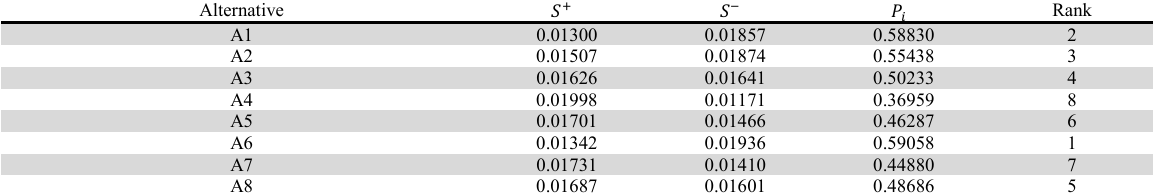
The final evaluation and ranking of the educational programs (alternatives) Alternative